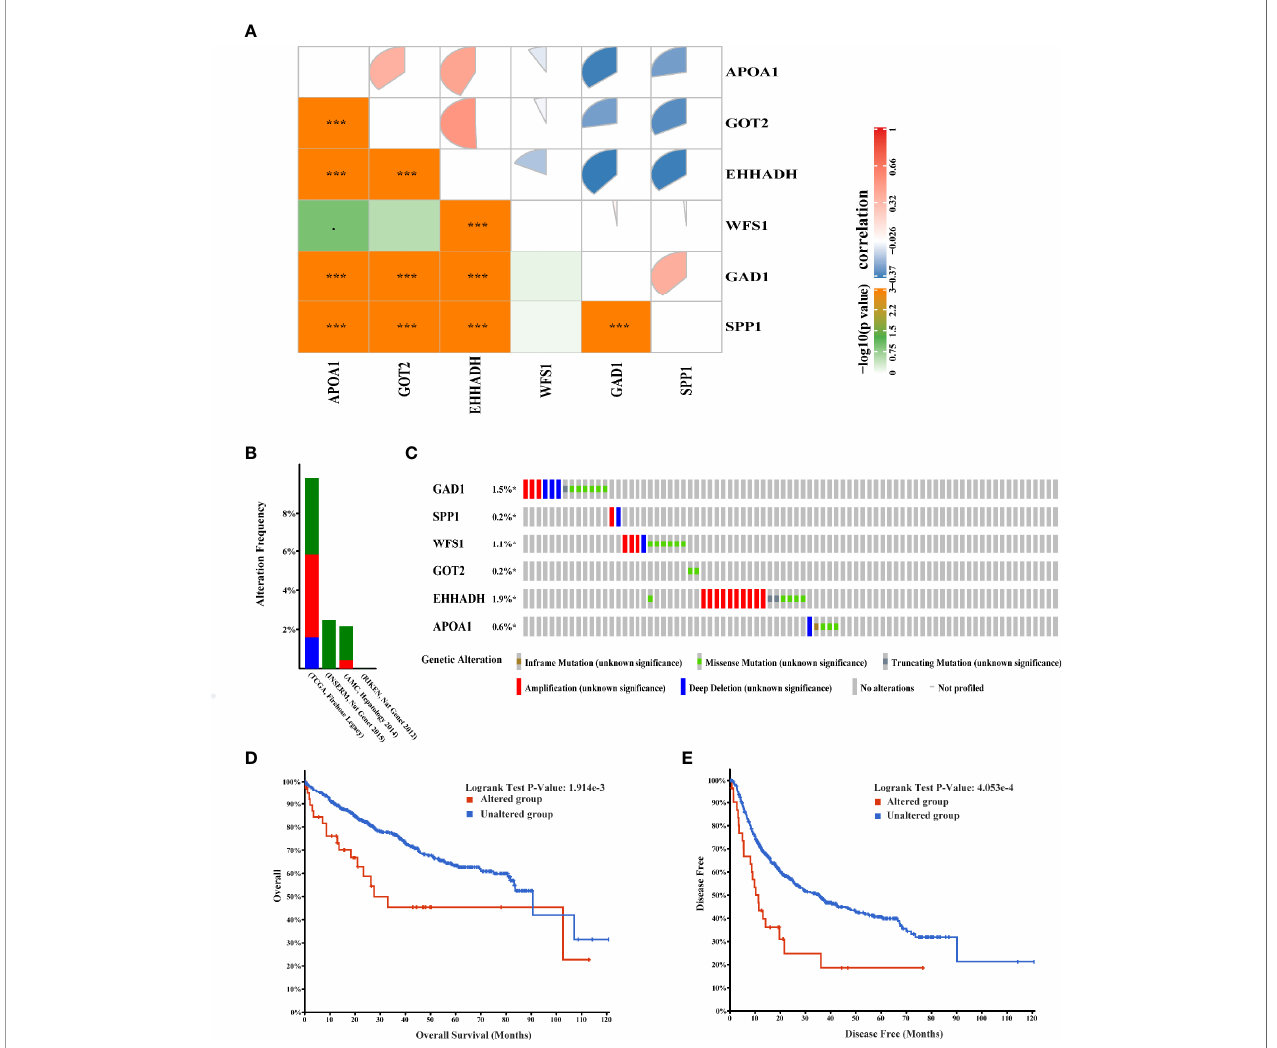
FIGURE 7 | Genetic alterations associated with six hub MRGs in HCC. (A) Pearson ’ s correlation analysis of six MRGs in TCGA. *p < 0.05; ***p < 0.001. (B) Alterations of the six MRGs in four datasets: Liver Hepatocellular carcinoma (TCGA, Firehose Legacy), Hepatocellular carcinomas (INSERM, Nat Genet 2015), Liver Hepatocellular carcinoma (AMC, Hepatology 2014), Liver Hepatocellular carcinoma (RIKEN, Nat Genet 2012). (C) Alteration frequencies of six MRGs were based on the four datasets described above. (D, E) Kaplan-Meier plots comparing OS and DFS in cases with and without alterations in the six